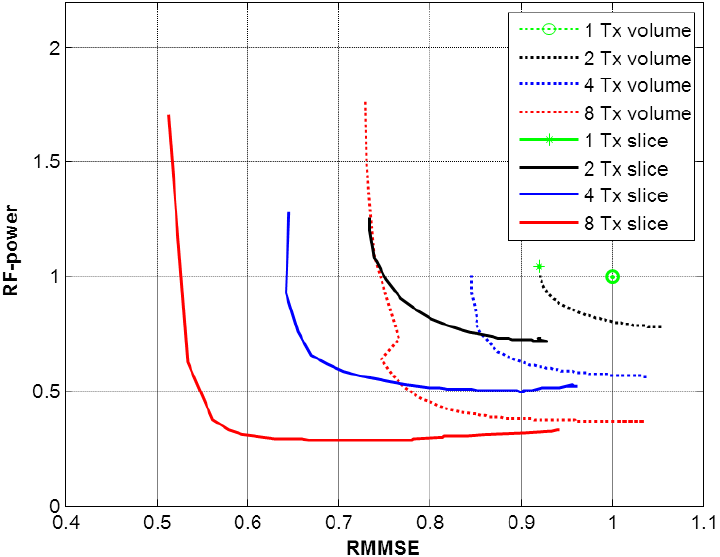
Figure 5. Tradeoffs between relative RF-power and RMMSE for 1-, 2-, 4-, and 8-channel Tx configurations for slice-selective and global RF shimming methods. Each curve is generated by performing the RF shimming calculation for multiple values of the regularization parameter λ. Different colors represent different numbers of Tx